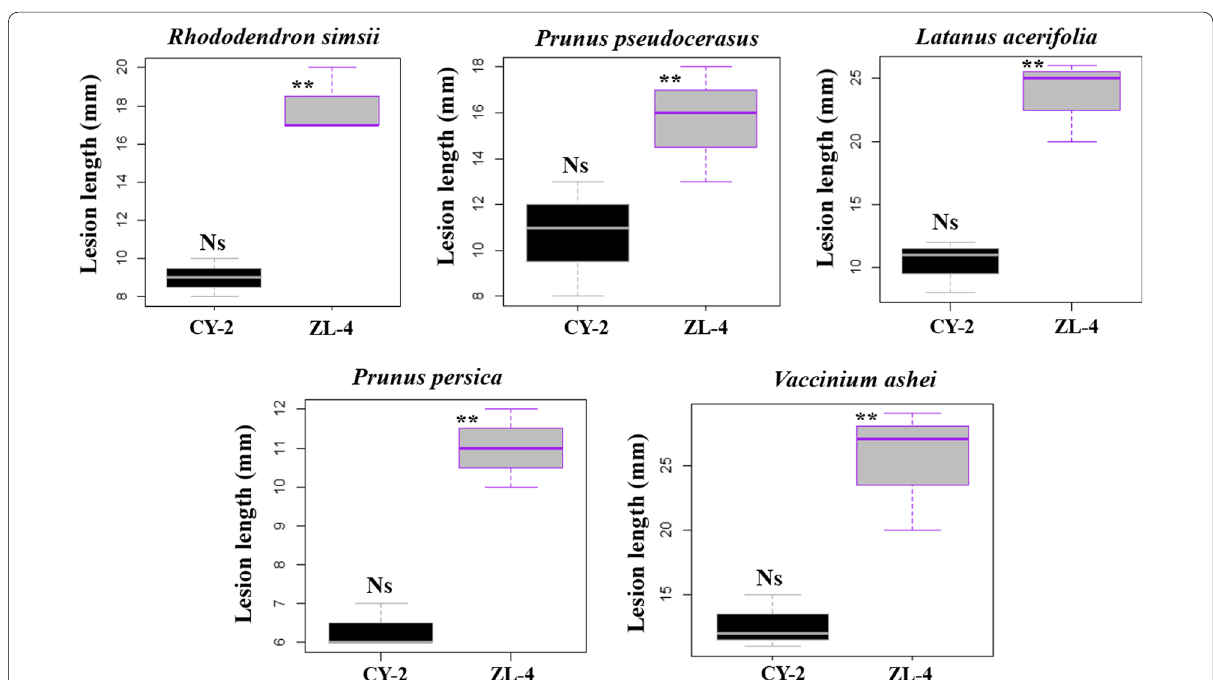
Fig. 6 Host ranges of the two N. parvum isolates. Lesion sizes caused by the two isolates on Prunus pseudocerasus , Prunus persica , Latanus acerifolia , Rhododendron simsii and Vaccinium ashei were measured at 2 dpi. Graphs were generated using R ggplot2. Data were analyzed using ANOVA. ** P <